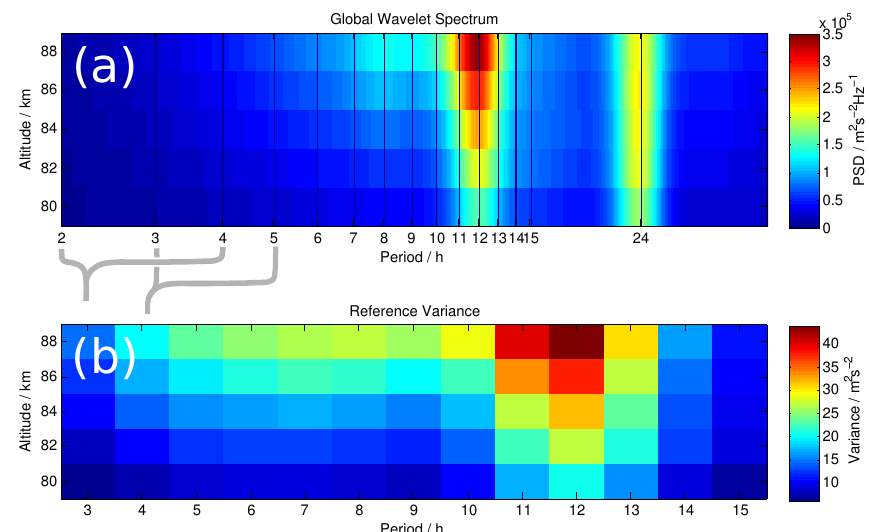
Fig. 1. (a) Global wavelet spectrum based on wind u data from 1 June to 15 August of the years 1999 to 2011. (b) Reference variances obtained from the global wavelet spectrum by summation of overlapping period bands of 2h width (see brackets below upper panel).